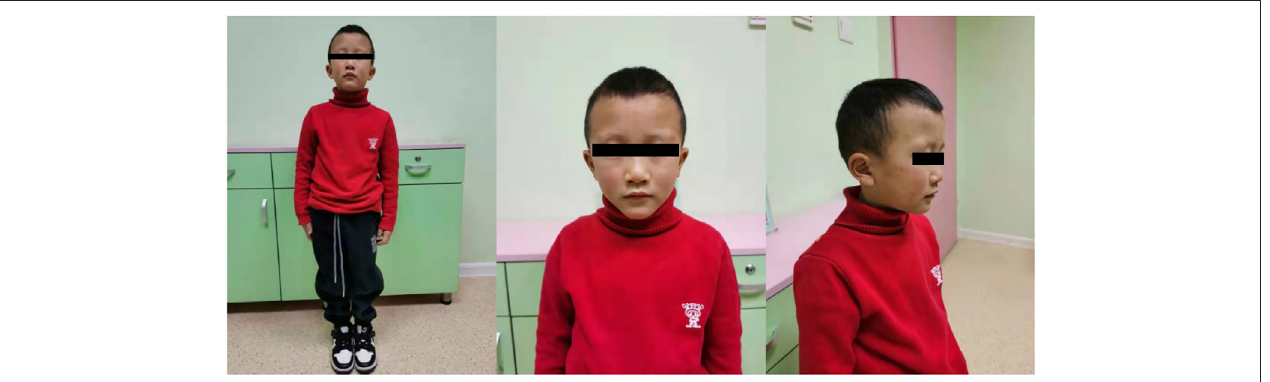
FIGURE 1 | Front and side view of the patient. The patient had a triangular face, small and pointed chin and sparse-hair eyebrows, and shortened left lower